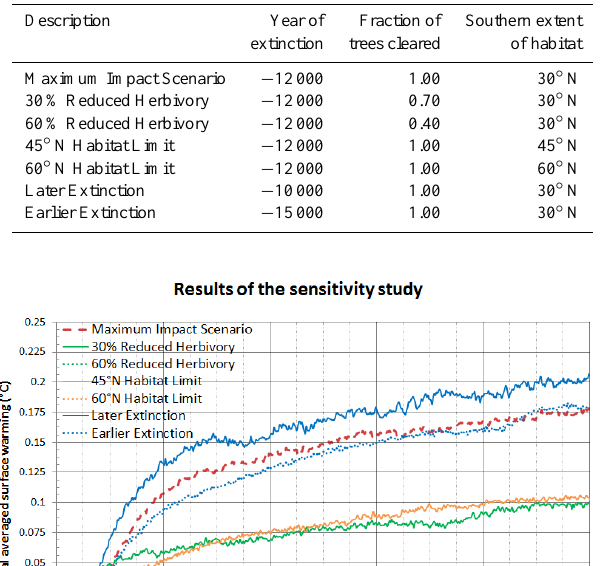
Table 1. List of sensitivity tests, performed for the three charac- teristics selected for this study: year of extinction, tree clearance fraction, and southern extent of mammoth habitat. For the sake of comparison, parameterizations for the MIS are shown in the first line.